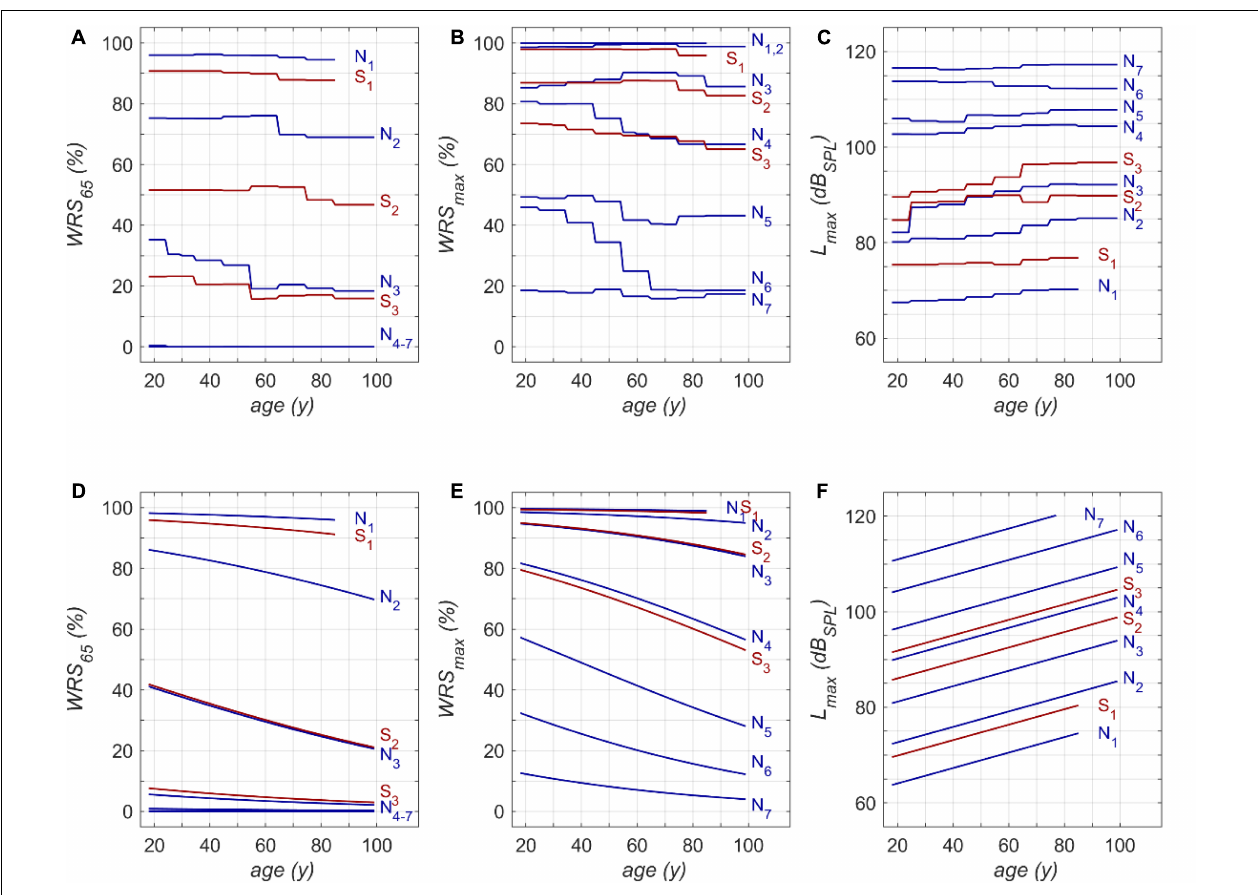
FIGURE 4 | Model results for RFR (A–C) and GLM (D–F) : (A) age dependence of monosyllabic score at 65 dB SPL presentation level (WRS 65 ), (B) maximum word recognition score (WRS max ) and (C) applied presentation level (L max ). N 1 to N 7 and S 1 to S 3 refer to the Bisgaard types of audiograms. The second row (D–F) shows the results of the GLM equivalent to the upper row (A–C) . WRS 65 and WRS max were calculated according to equation 1 (D,E) . L max was calculated according to equation 2 (F)